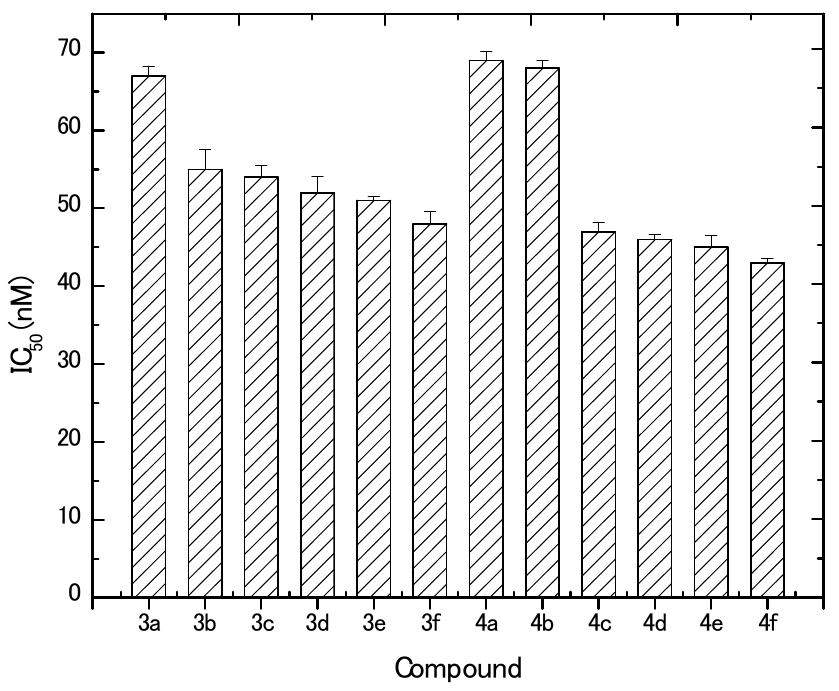
Figure 3. IC 50 values obtained for different synthesized compounds against MCF-7.